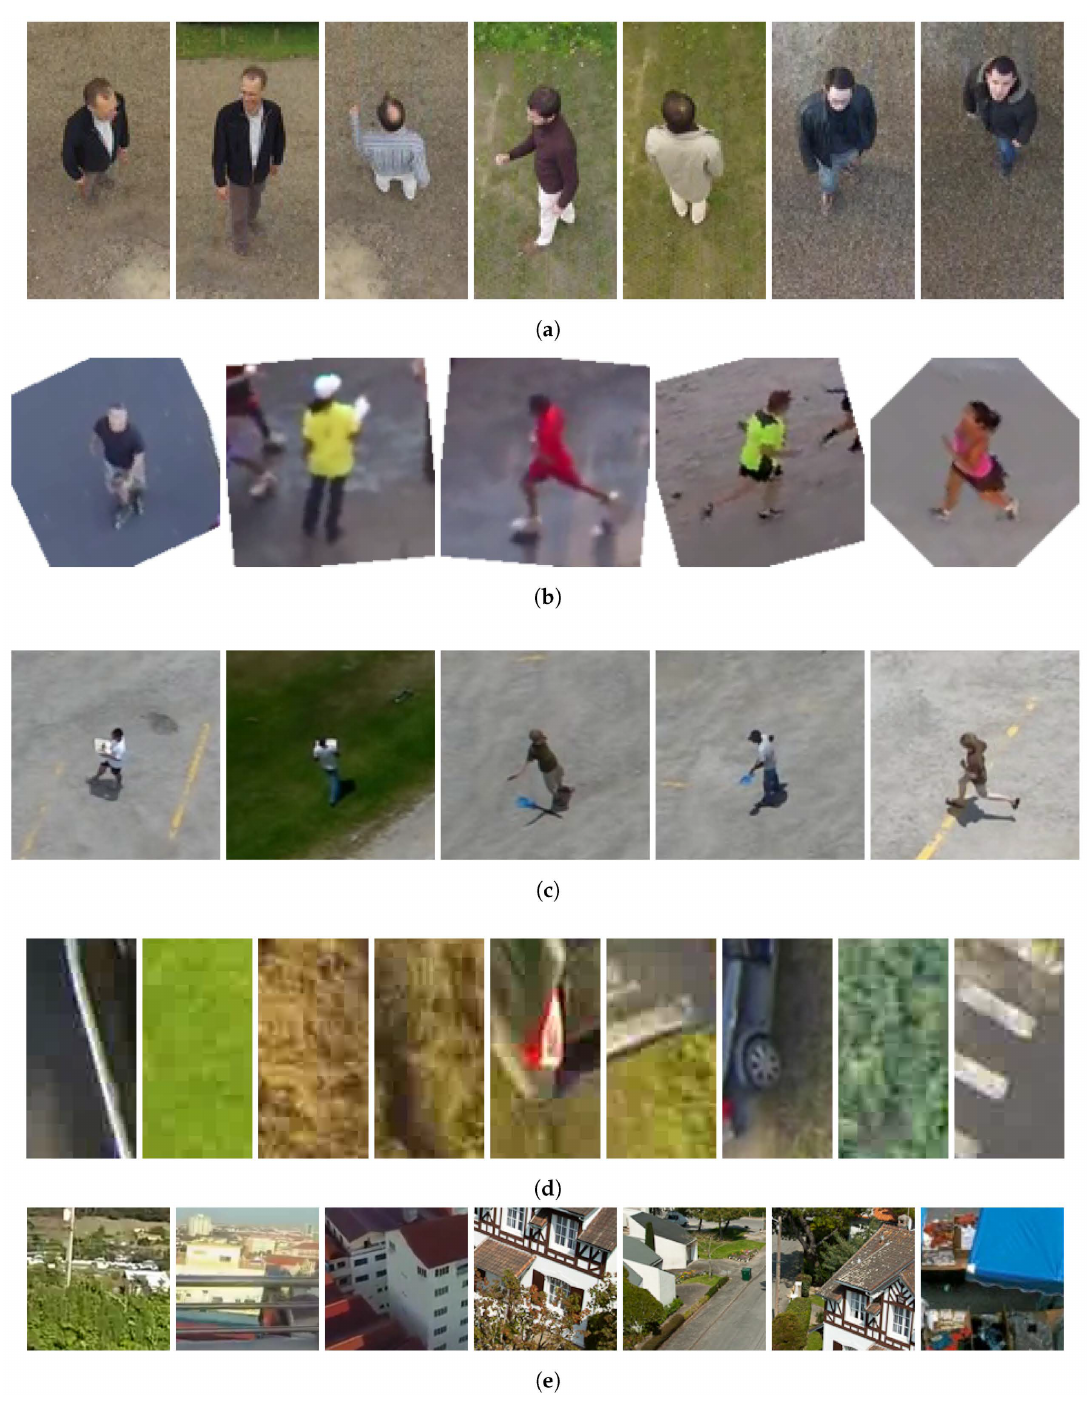
Figure 4. Samples of the aerial images datasets used in this study: ( a ) pedestrian images from GMVRT-v1; ( b ) pedestrian images from GMVRT-v2; ( c ) pedestrian images from UCF-ARG; ( d ) non-pedestrian images from GMVRT-v1 and ( e ) non-pedestrian images from